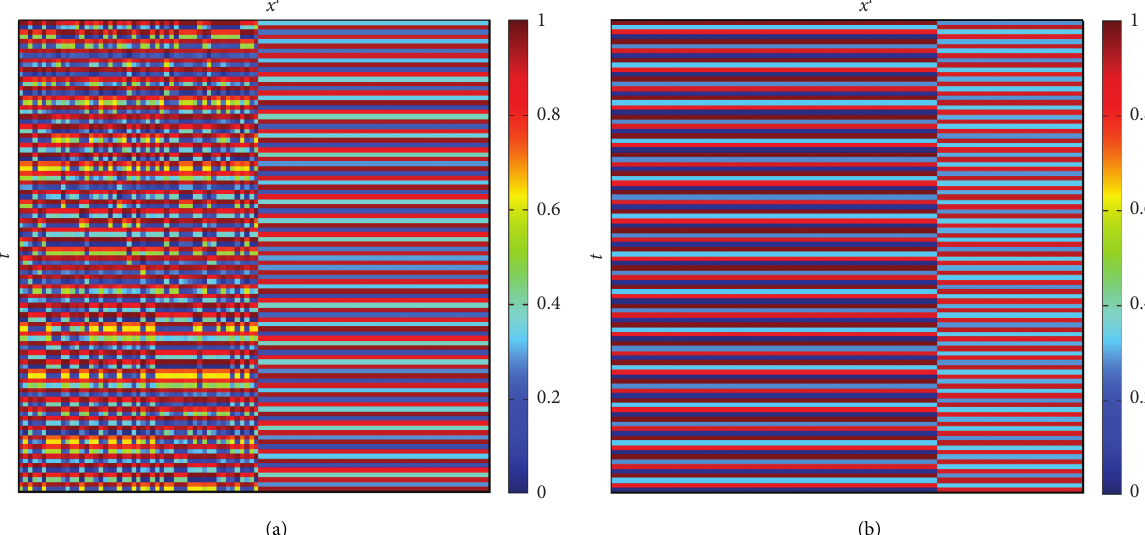
Figure 7: Asymptotic evolution of the states x i (horizontal axis) as a function of time (vertical axis) for driven system equation (15) with size N � 100 and local map equation (9), for different values of the coupling parameter. Fixed values: A � 0 . 48, k � 0 . 4, b � 0 . 5. Random initial conditions x i are uniformly distributed in the interval [ 0 , 1 ] . After discarding 10 4 transients, 100 iterates t are displayed. Ordering of the 0 maps is similar to that in Figure 2. Color code: two elements i, j share the same color if x i t � x j t . (a) Chimera state, ε � 0 . 198. (b) Two-cluster state, ε � 0 .